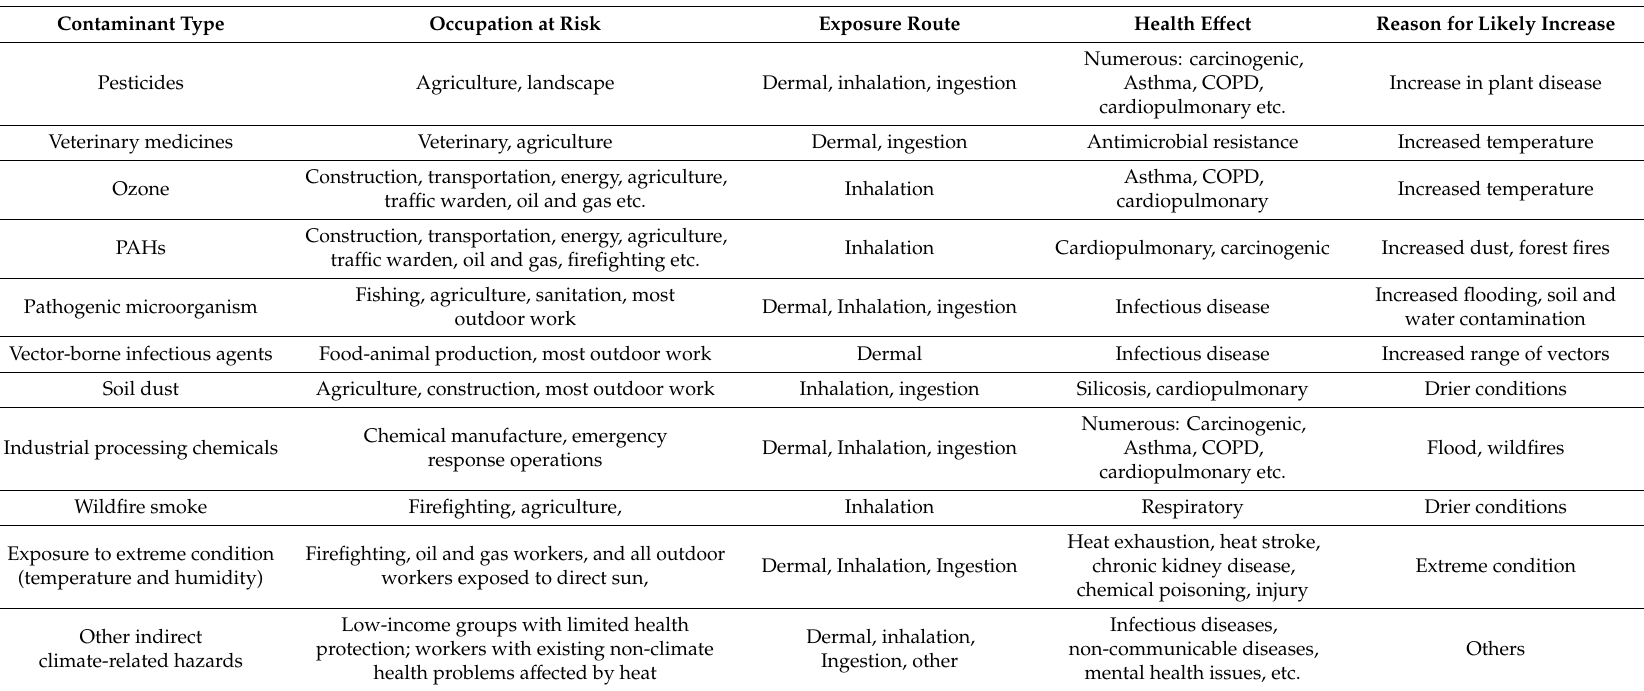
Table 4. Potential impact of climate change on occupational sectors by exposure